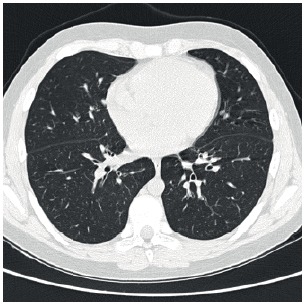
TCAR de tórax revelando tênue adensamento do parênquima pulmonar de
ambos os pulmões, com distribuição heterogênea; pequenos nódulos de limites
mal definidos e alterações em vidro fosco.